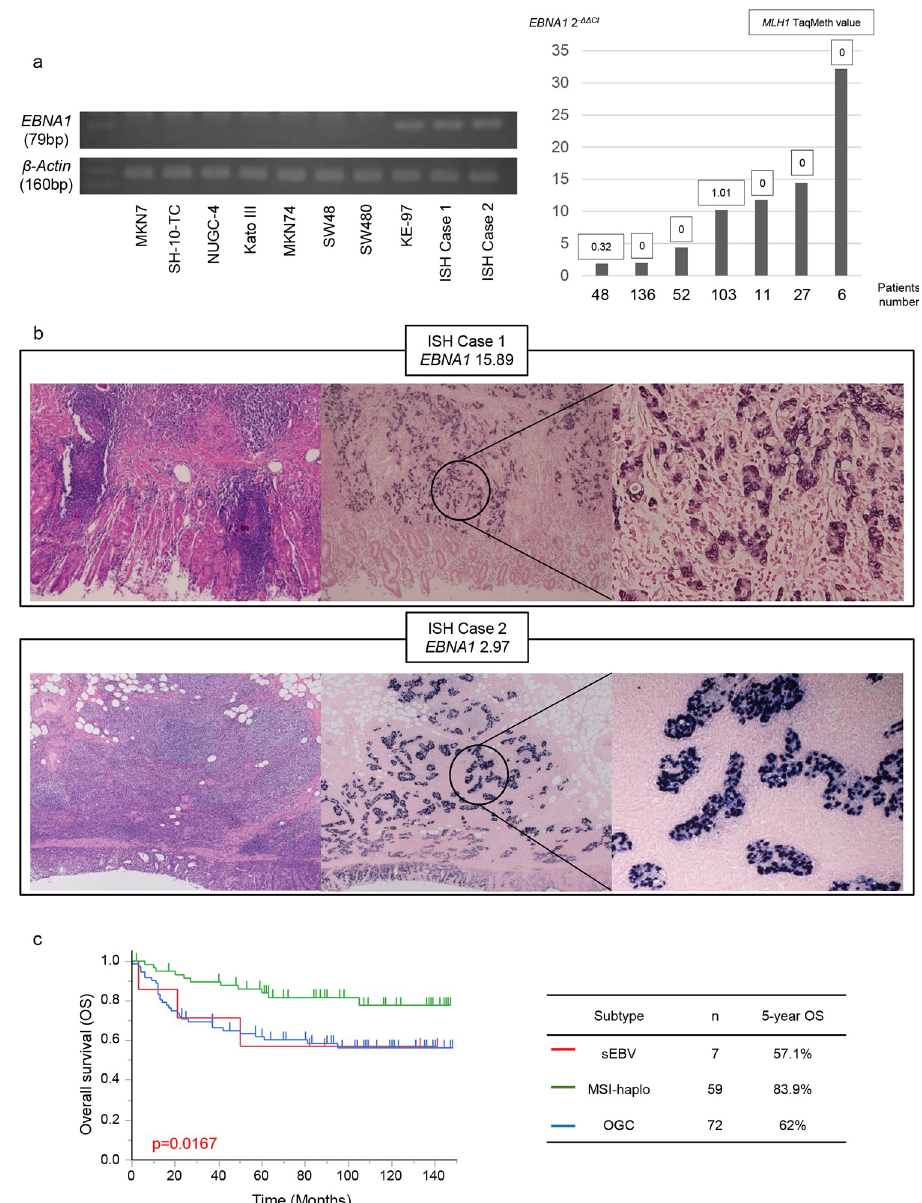
Fig 6. (a) Results of RT-PCR (left panel) using gastric cancer cell lines, colon cancer cell lines and in situ hybridization (ISH) positive cases in EBNA1 and β -actin . Gastric cancer tissues with cases of equal to or over 1 in quantitative real- time PCR of EBNA1 . MLH1 TaqMeth values of these EBNA1 positive cases (right panel). (b) Histological images of two cases confirmed positive for Epstein Barr virus (EBV) by ISH. Each EBNA1 quantitative value. (c) Kaplan-Meier survival curves for overall survival comparing gastric cancer patients with MSI-haplo (n = 59), EBNA1 positive (n = 7) and other gastric cancers (OGC) (n = 72) ( P = 0.0167). patients [23], we finally compared MLH1 methylation and CDO1 methylation in gastric can- cer. MLH1 hypermethylation was significantly associated with CDO1 hypermethylation (R = 0.433, P < 0.0001) (S3 Fig), and MSI status was also significantly correlated with CDO1 hypermethylation like MLH1 hypermethylation (Fig 4C), suggesting that MSI carcinogenesis may be associated with pan-epigenetic alterations. Combination of MLH1 and CDO1